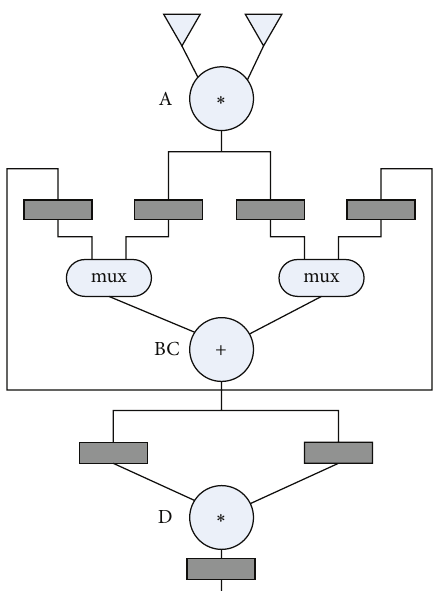
Figure 3: RTL structure of PLF using two ports and minimum functional